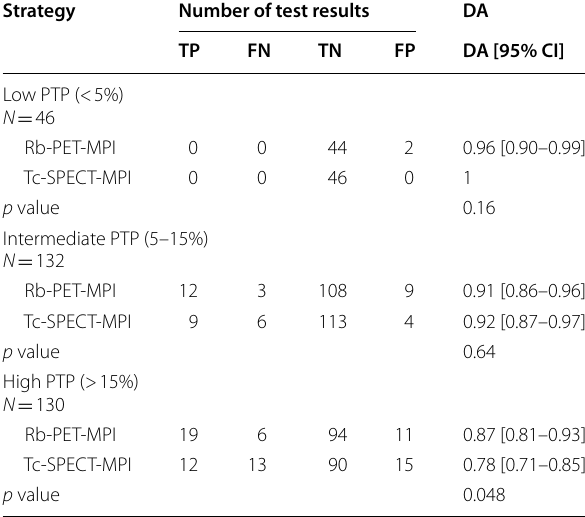
Table 3 Diagnostic accuracy of Rb‑PET‑MPI and Tc‑SPECT‑MPI diagnostic strategies in each subgroup (results in